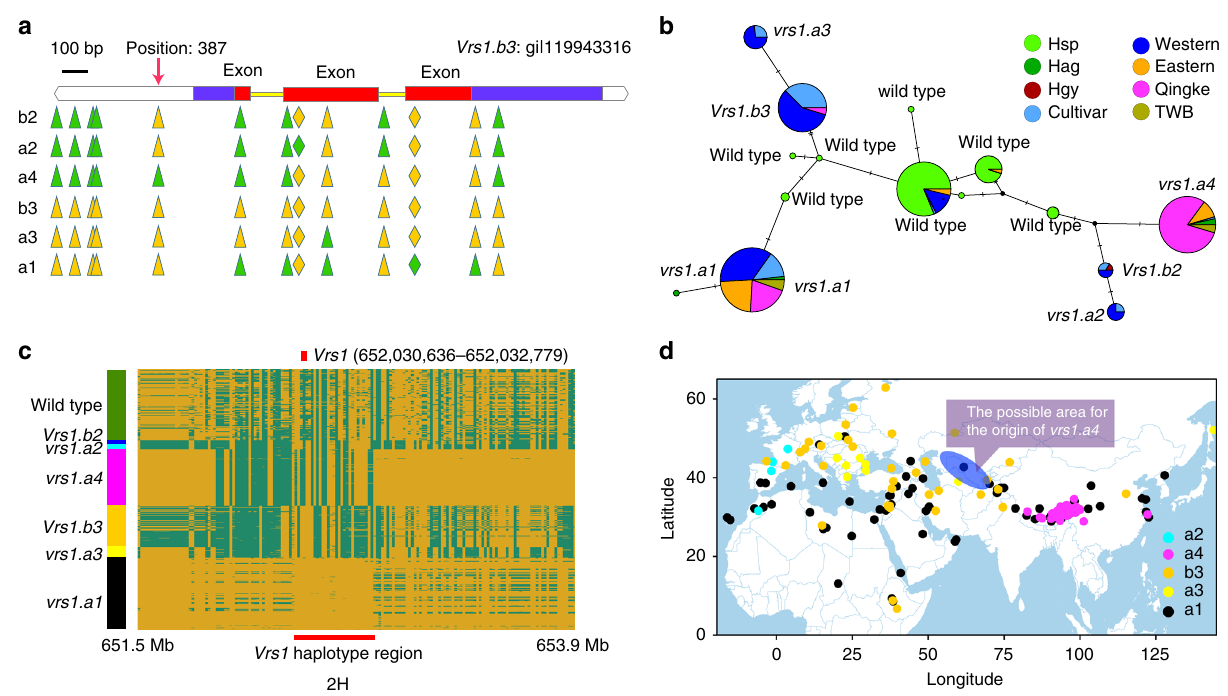
Fig. 6 Molecular and spatial variants in Vrs1 . a Gene structures (exon: red bar; intro: yellow bar; UTR: blue bar) of Vrs1 with the relative positions of the SNPs (triangle) and INDELs (rhombus), respectively. The golden triangle or rhombus indicates the same genotype compared with the reference gene sequences ( Vrs1.b3 : gi|119943316) and the lime green indicates difference. The vrs1.a4 alleles differ from other domesticated Vrs1 alleles by a unique SNP ( G / T ) in position 387 of the Vrs1.b3 sequences. b Median-joining networks Vrs1 haplotypes of barley accessions based on Vrs1 SNPs. The INDELs were considered as SNPs for distinguishing b2 and a2. Hsp H. spontaneum , Hag H. agriocrithon , Hgy H . var . gymnospermum Korn , TWB Tibetan weedy barley. Three two-rowed qingke cultivar accessions which mixed with pedigree of two-rowed barley, carried the allele Vrs1.b3 . c Degree of haplotype diversity around the Vrs1 locus in the barley genome. The golden region of corresponding accessions indicates the same genotype compared with the barley genome (Morex: Vrs1.a1 ); and the green region indicates difference. d Haplotype distributions according to geography for Vrs1 . The six Vrs1.b2 accessions were not shown on the map because of the absence of clear geographical location. Uzbekistan highlighted by blue ellipse was the possible origin area of Vrs1.a4 reported by Pourkheirandish et al. 11 . d was generated in R (V3.4.3) using packages maps, maptools, plyr, ggrepel, and ggplot2. Geographic information data were obtained from Global Administrative Areas database (GADM V2.8, November 2015). Source data are provided as a Source Data fi